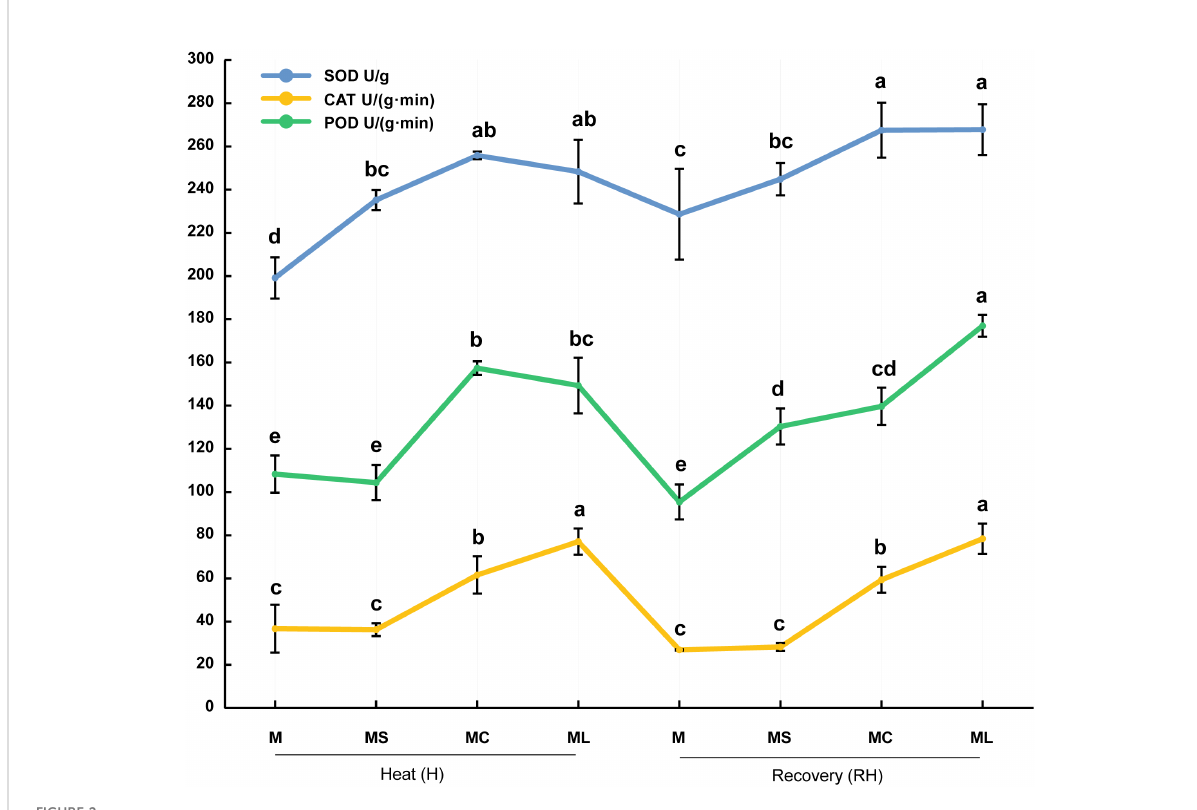
FIGURE 2 Activity of antioxidant enzymes. Values are the mean (± SE) of three replicates. Different letters indicate statistically signi fi cant differences between the treatment groups ( P<